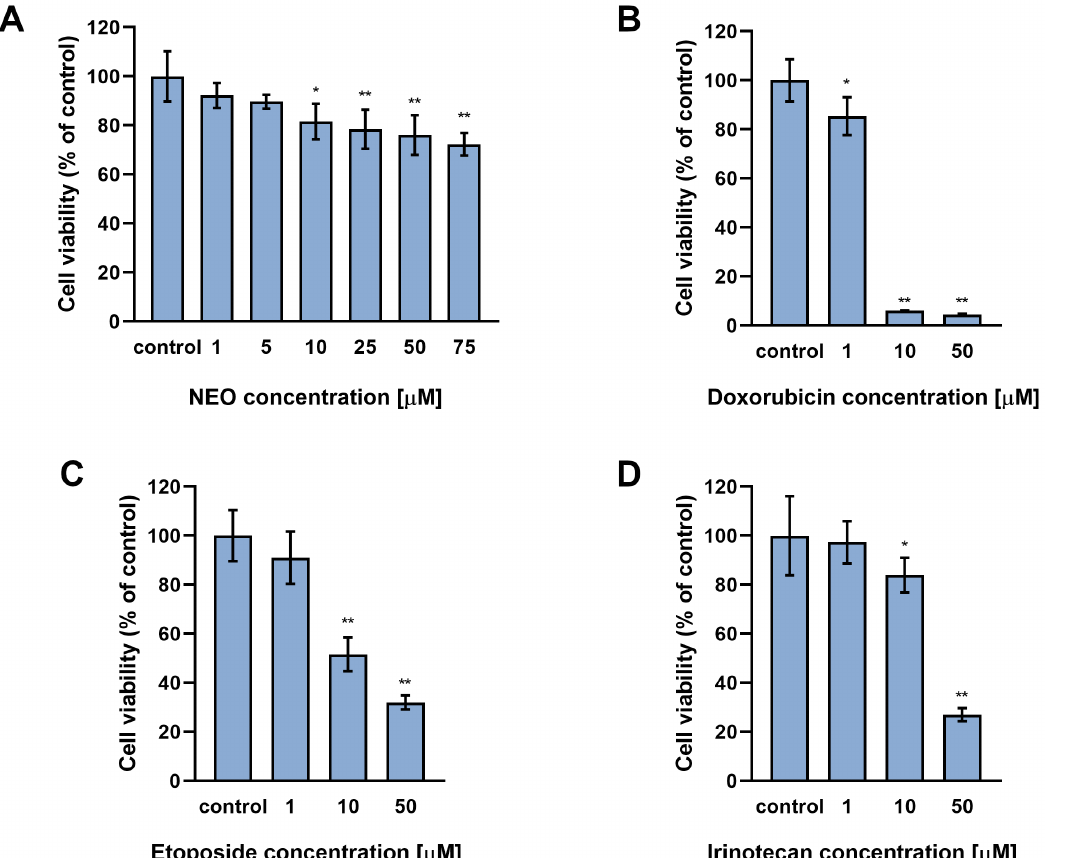
Figure 1. The impact of NEO ( A ), doxorubicin ( B ), etoposide ( C ), and irinotecan ( D ) on the viability of SW1783 cells. Cells were incubated with substances at indicated concentrations for 48 h and examined by the WST-1 test. The results are presented as a percentage of the controls. * p < 0.05, ** p < 0.001 vs. control.